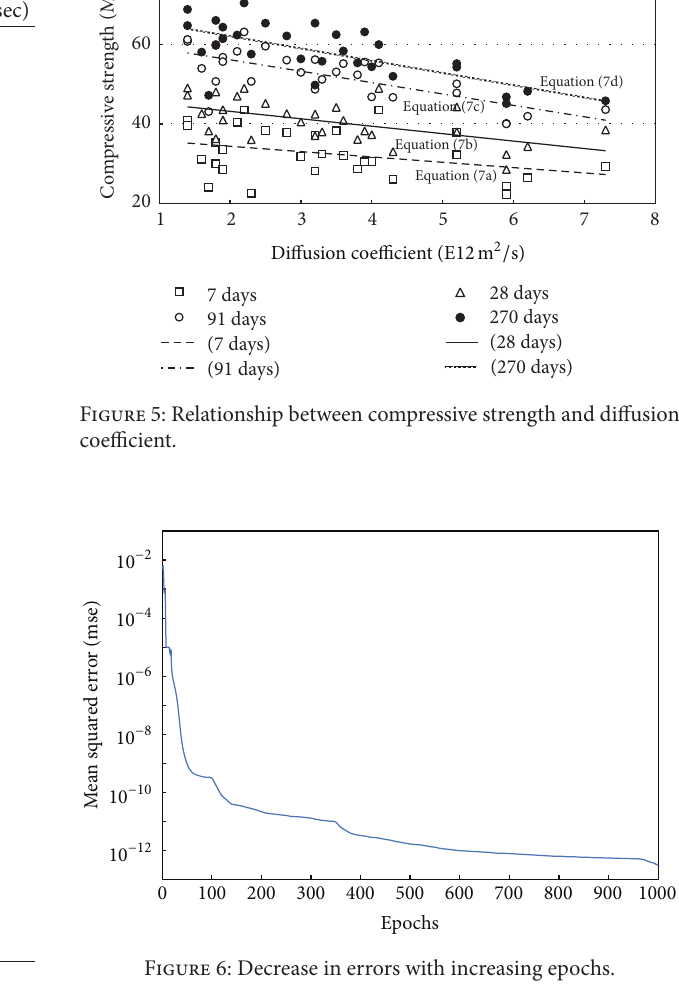
Table 4: Results of apparent diffusion coefficient.